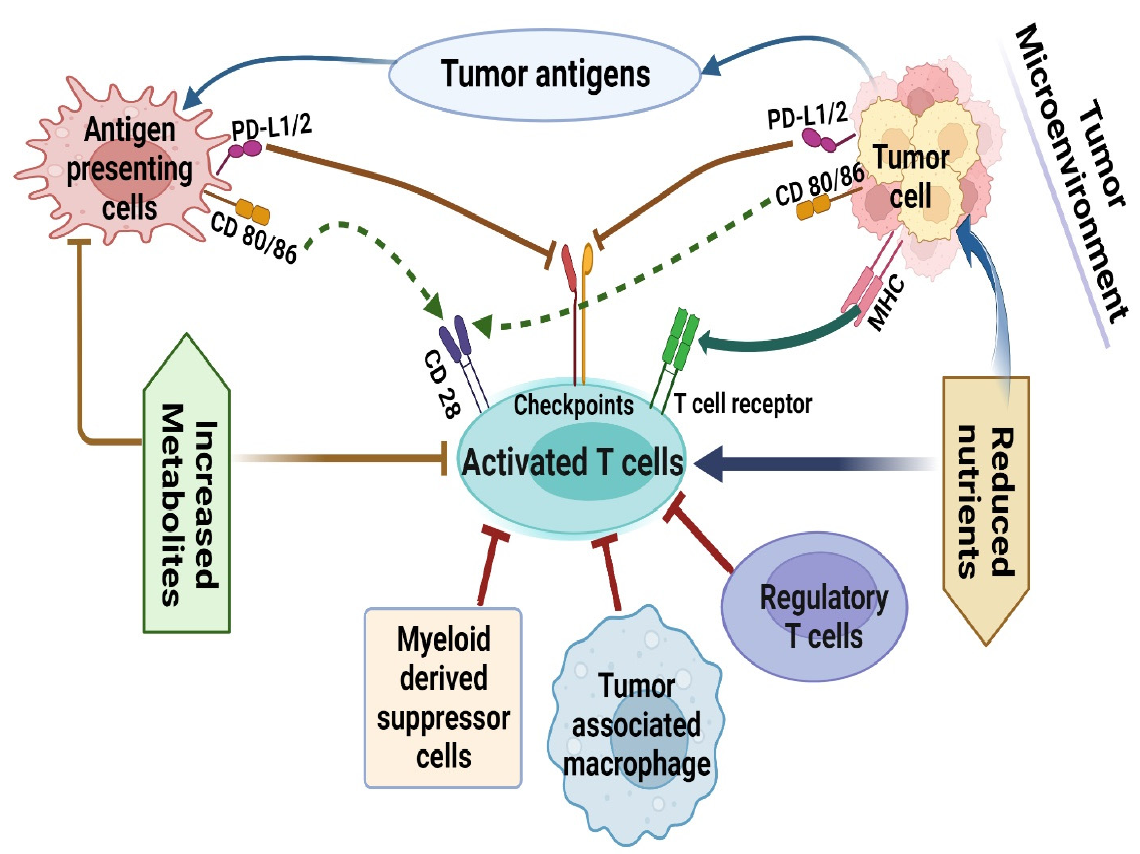
Figure 1. Regulation of immune response by nutrients in a tumor microenvironment. In a tumor microenvironment reduced nutrients and elevated immunosuppressive metabolites modulate the immune response to a tumor. The red line (with bar) denotes inhibition whereas the green dotted line (with arrow) denotes activation.